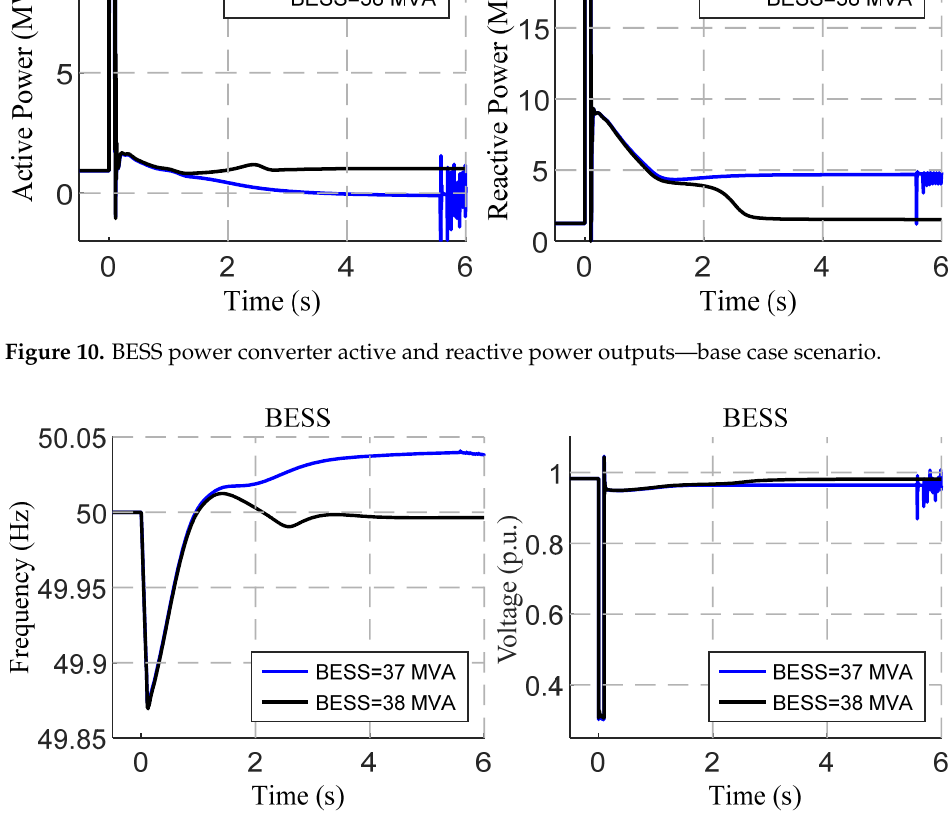
Figure 11. BESS power converter synthetic frequency and terminal voltage—base case scenario.